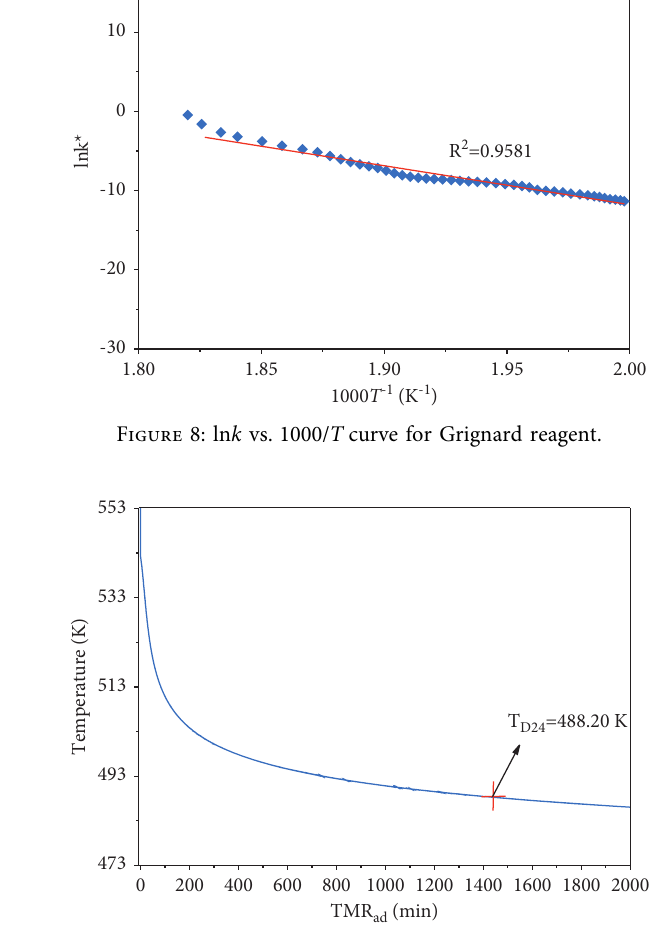
Figure 9: TMR ad vs. temperature curve for Grignard reagent under adiabatic Table 3: Thermal parameters for decomposition of Grignard reagent.